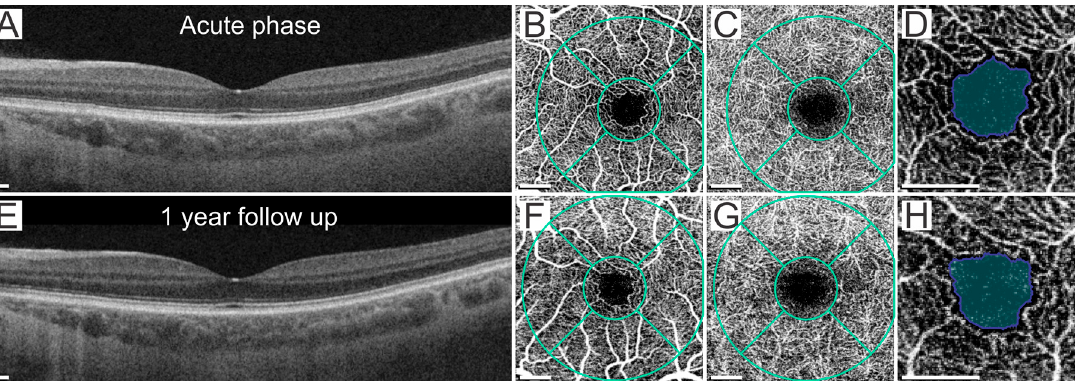
Figure 3. Comparison of the OCT and OCTA images of a single patient in the acute phase and at a 1-year follow-up. ( A , E ). OCT B-scan, note the thinner RNFL layer. ( B – D , F – H ). Segmentation of 3 × 3 mm OCTA images in the macular superficial capillary plexus ( B , F ) and in the macular deep capillary plexus ( C , G ). Foveal avascular zone area ( D , H ). Scale bar in all images: 0.5 mm. Table 1. Demographic and clinical characteristics of patients in the acute phase of COVID-19.